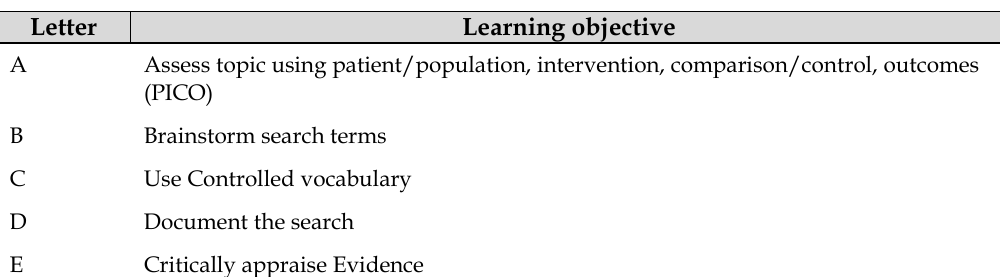
(Table 2): “ABCDE” to outline the steps of an effective bibliographic literature database